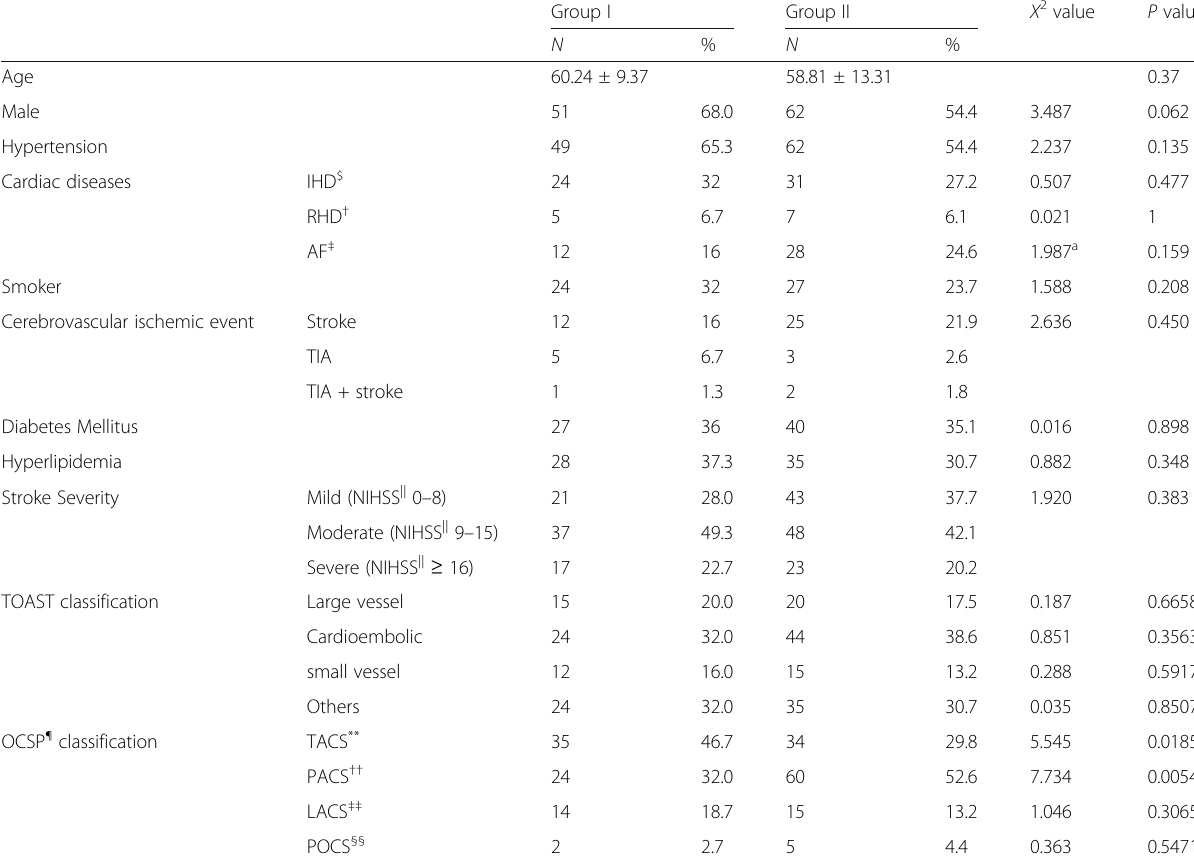
Table 1 Demographic and baseline characteristics of both